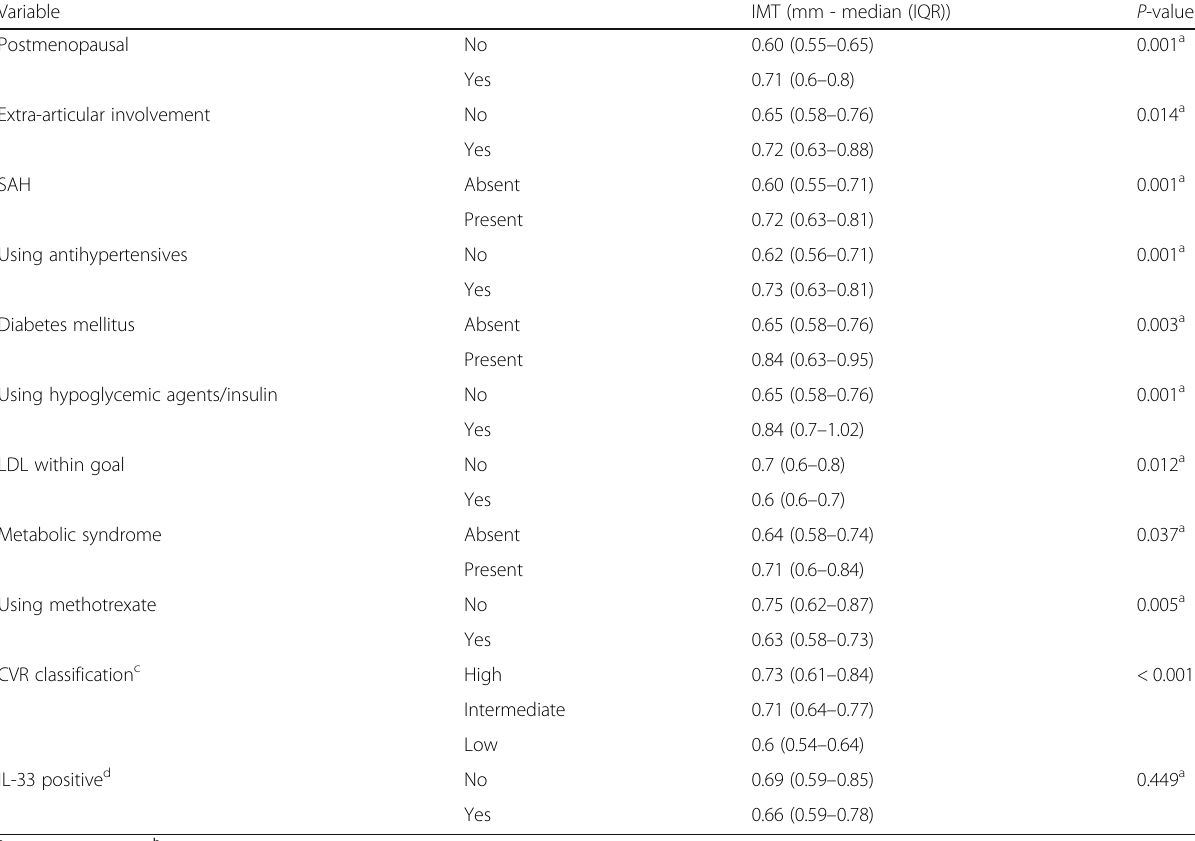
Table 5 Correlation of IMT with demographic, clinical and laboratory characteristics Variable IMT (mm - median